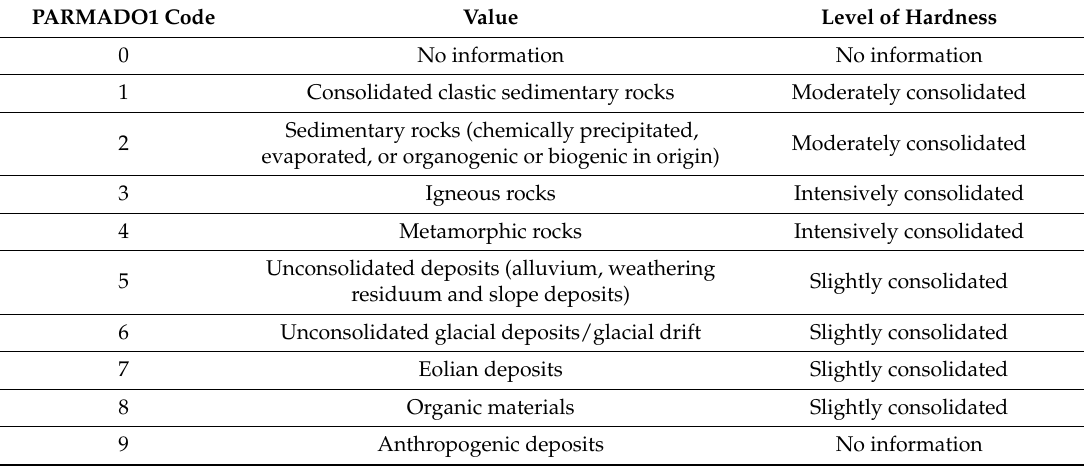
Table 2. Assumed hardness levels of PARMADO1